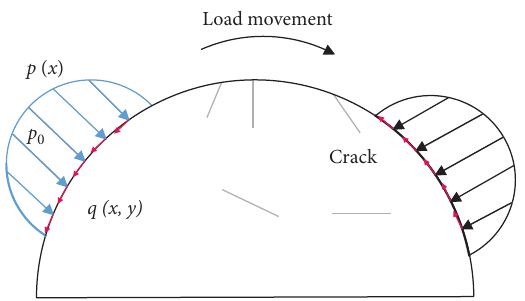
Figure 3: The loading process of the ceramic bearing ball.